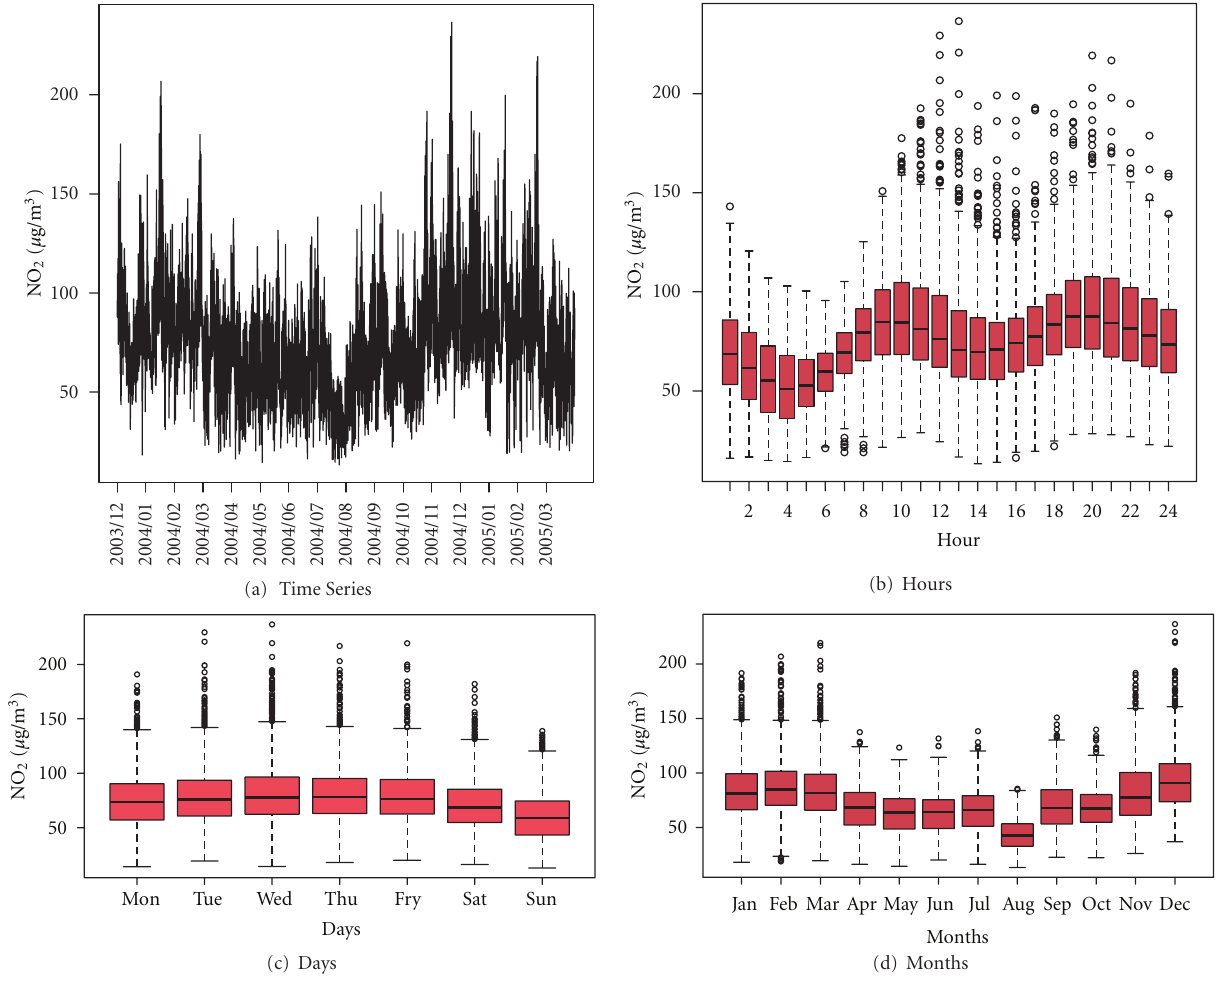
Figure 3: Time series and box plots for NO 2 concentration measured at Consolata